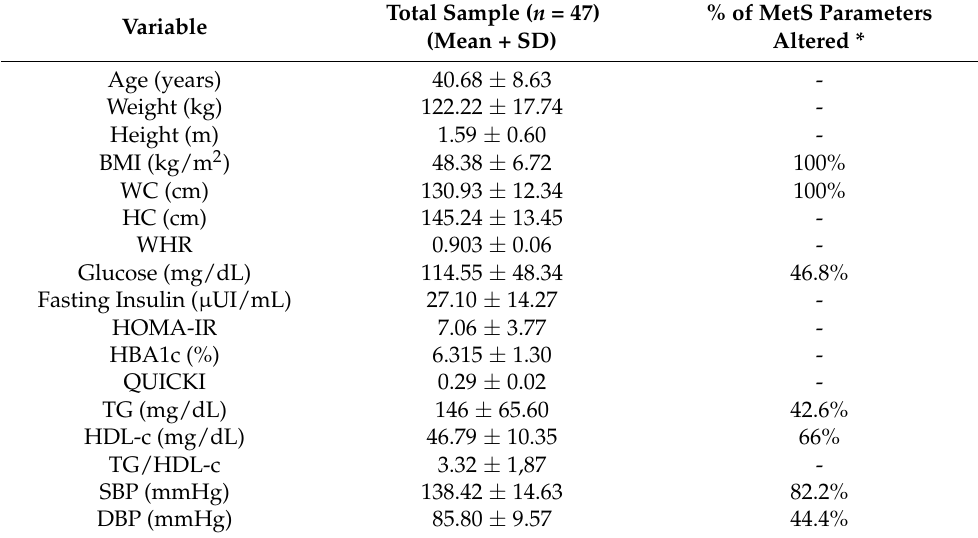
Table 1. General